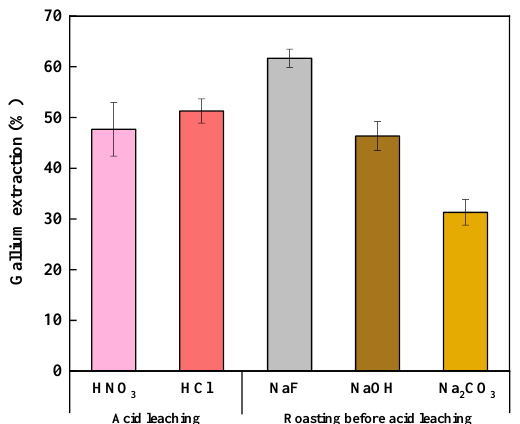
Figure 2. Gallium extraction from CFA through acid leaching or roasting before acid leaching (the reagent-CFA mass ratio of 1:1, roasting temperature of 800 °C, roasting time of 20 min, leaching temperature of 120 °C, leaching time of 1 h, and HNO 3 concentration of 2 mol/L).